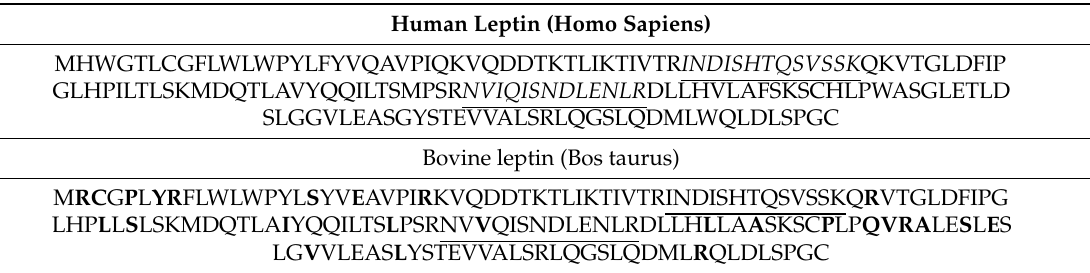
Table 2. Comparison between sequence of human (UniProt KB code P41159, Homo sapiens (Human)) and bovine (UniProt KB code P50595, Bos taurus (Bovine)) leptin. Bold letters denote the di ff erent amino acids between human and bovine leptin sequence. Italic and underline letters indicate the selected peptides to qualify and quantify human leptin. The first peptide is in common between species. Human Leptin (Homo Sapiens) MHWGTLCGFLWLWPYLFYVQAVPIQKVQDDTKTLIKTIVTR INDISHTQSVSSK QKVTGLDFIP